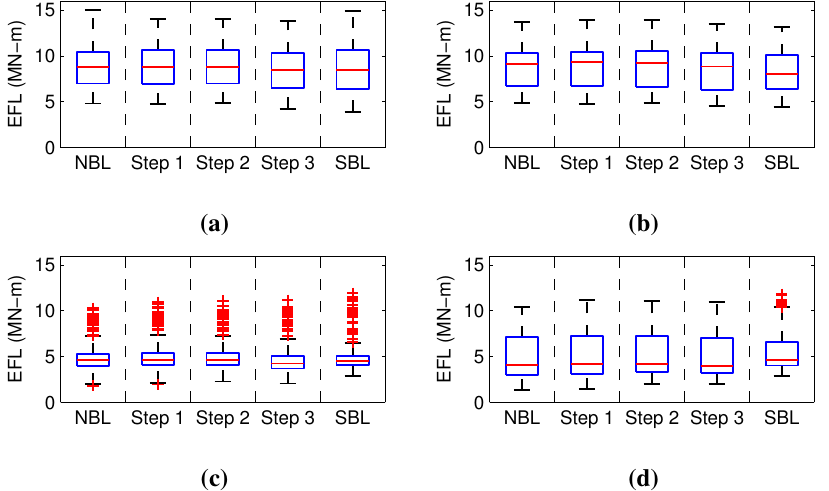
Figure 29. EFL statistics for FATBM from 2200 wind fields (SBL versus baseline NBL and < 0 modified cases). ( a ) z α